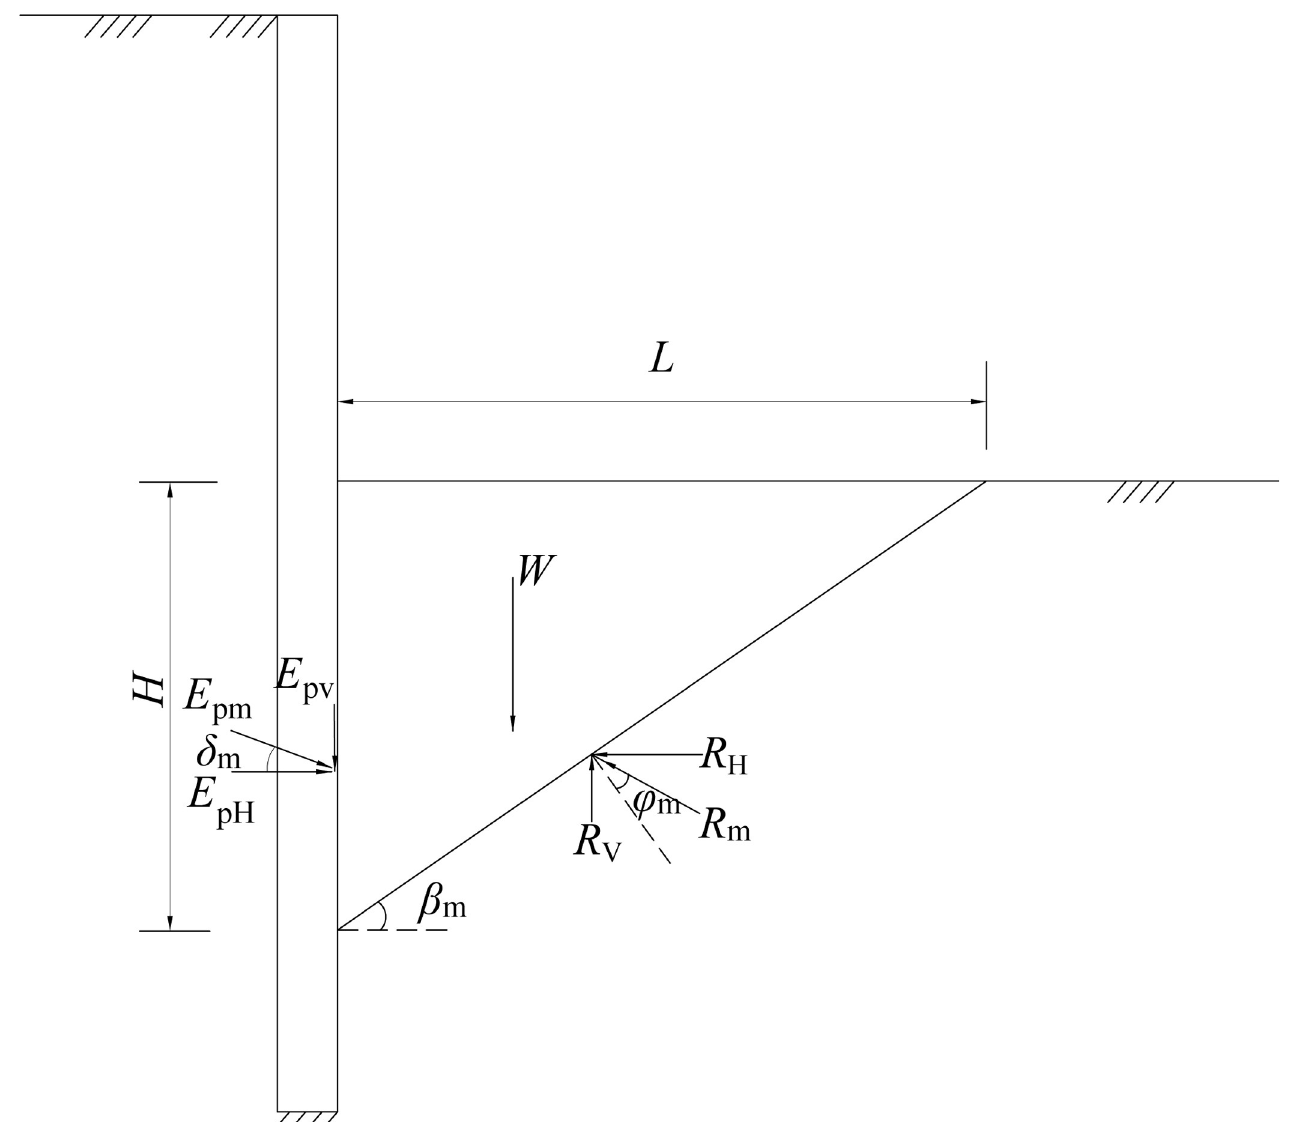
Fig 12. Stress mechanism of soil wedg (non-limit